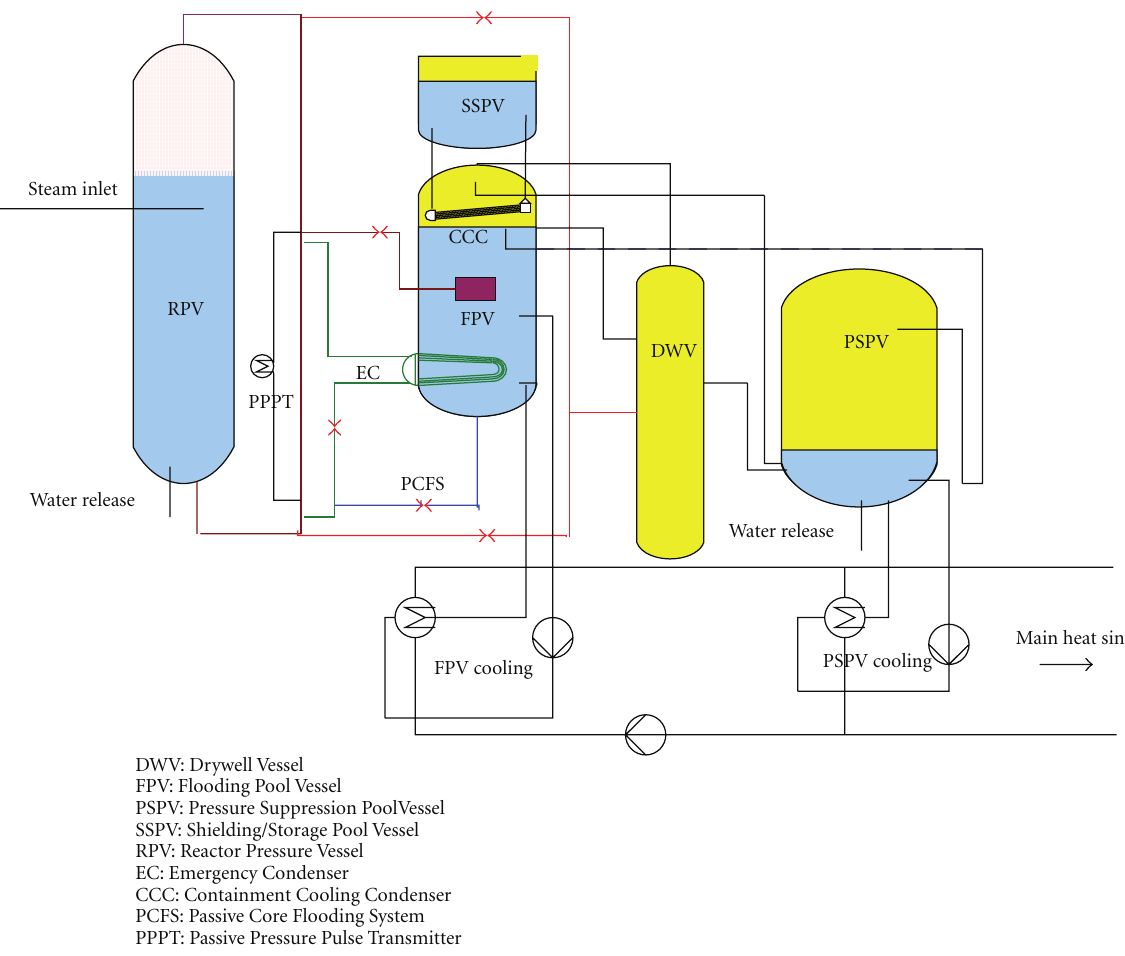
Figure 4: Simplified P&ID of the INKA Test